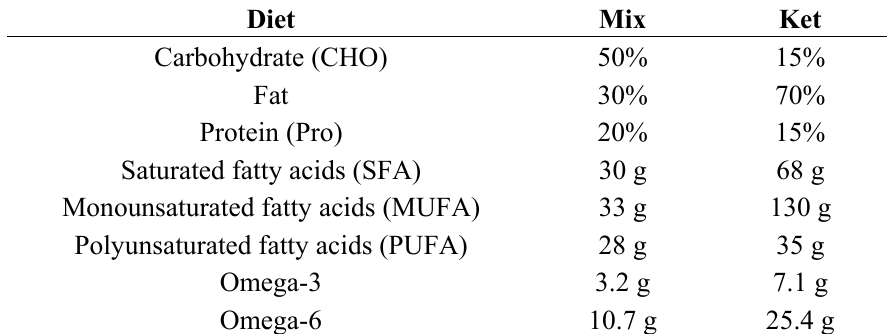
Table 2. Diet composition of the off-road cyclists with particular types of fatty acids. Ket,